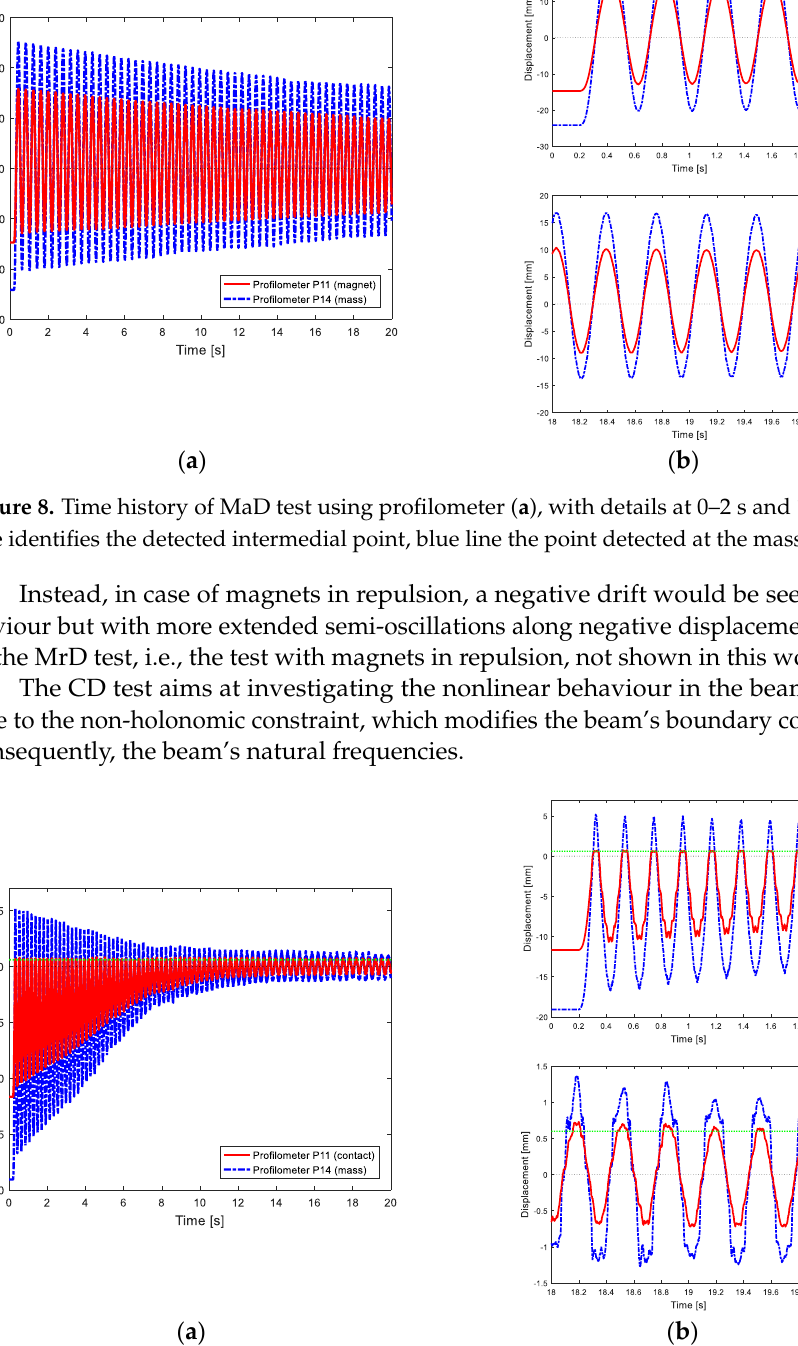
( b ) Figure 7. Time history of BD test using profilometer ( a ), with details at 0 – 2 s and 18 – 20 s ( b ); red line identifies the detected intermedial point, blue line the point detected at the mass. Instead, in Figure 8, the time histories of the MaD test, i.e., the test with magnets in